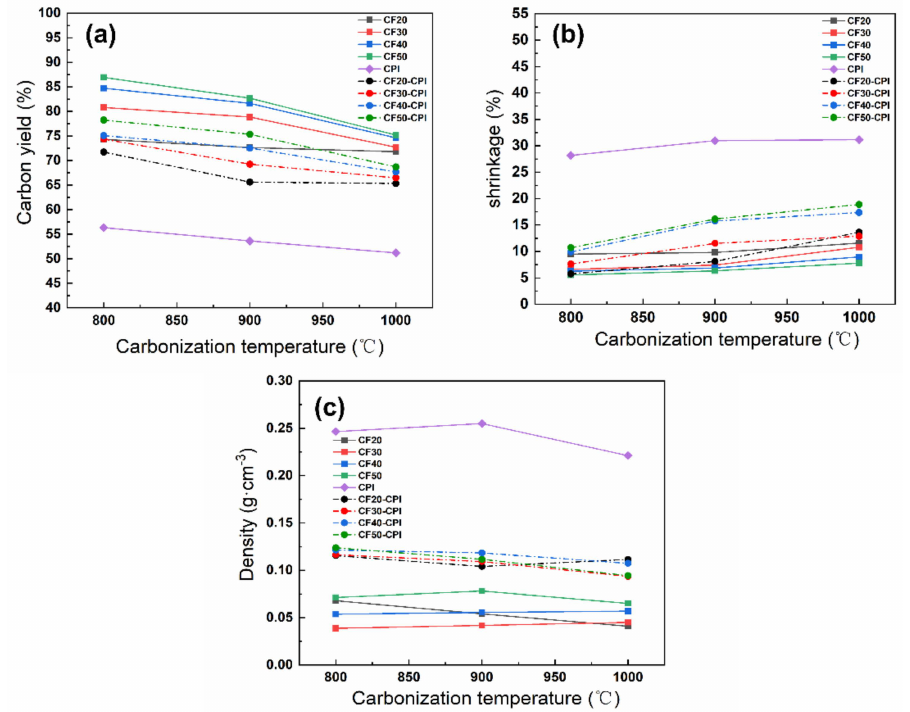
Figure 4. The effect of carbonization temperature on ( a ) the carbon residue rate, ( b ) the shrinkage and ( c ) the density of polyimide aerogels, pre-carbonized foams and